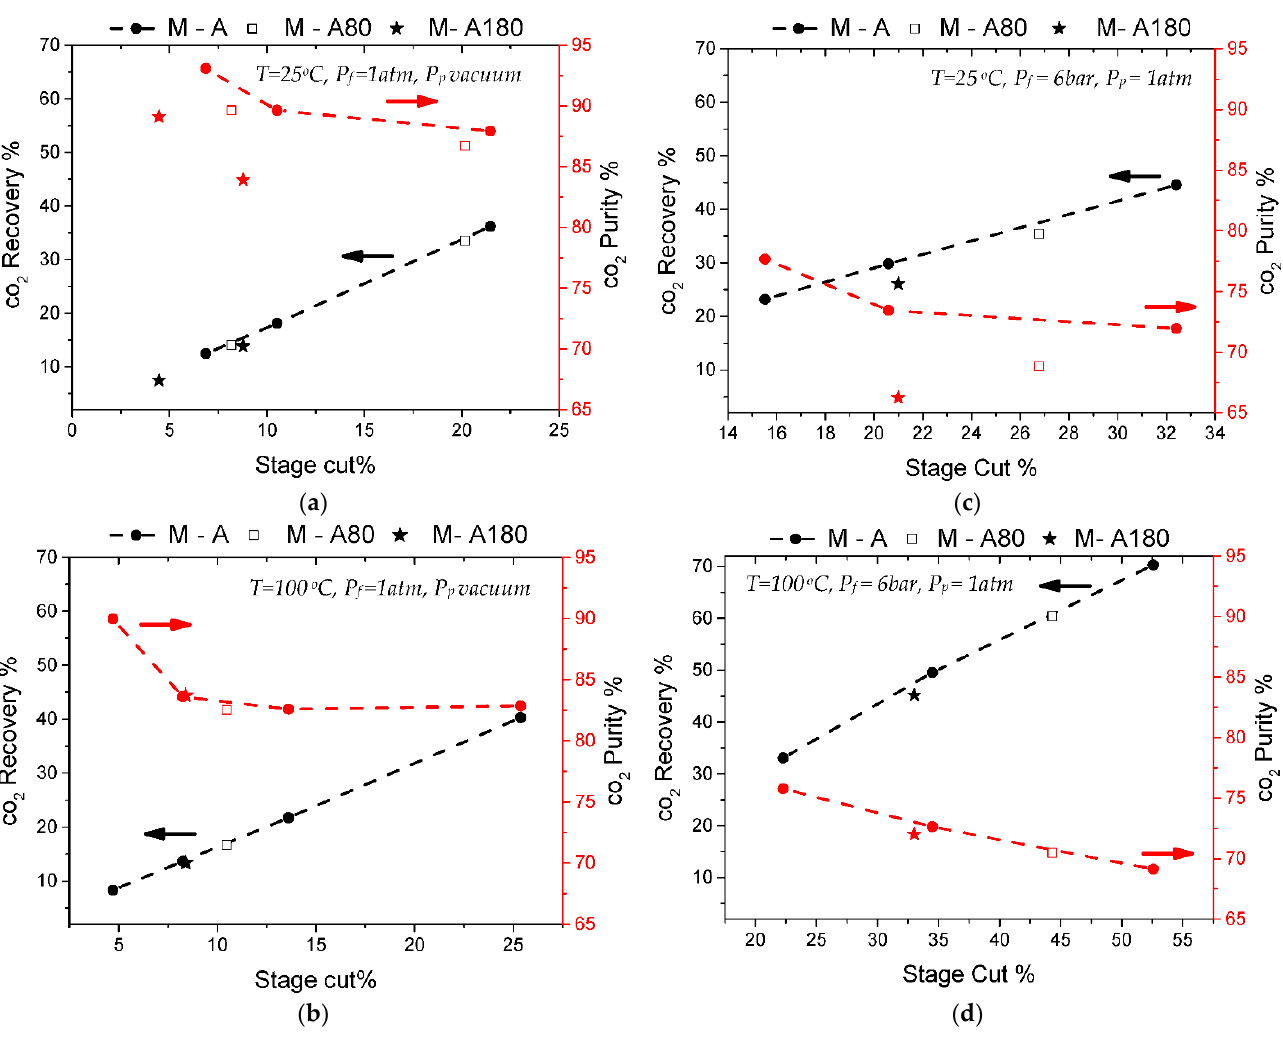
Figure 4. Results of CO 2 /N 2 (50/50) separation tests at 25 °C ( a , c ) and 100 °C ( b , d ) either implementing vacuum on the permeate side ( a , b ) or 6 bar pressure on the feed side ( c , d ). All plots include recovery % and purity % data as a function of stage-cut % for the commercial M-A membrane, compared with results from each stage of its modification (M-A80 and M-A180).